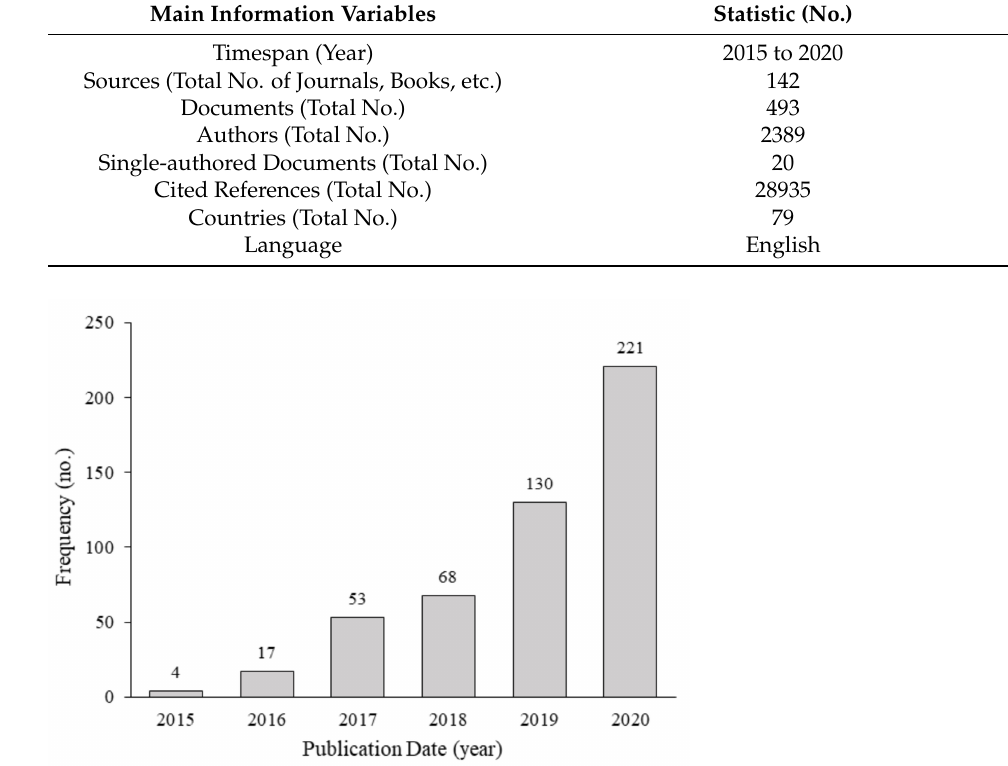
Figure 2. The change in publication frequency over time from 2015–2020 as recorded in the Web of Science for the keyword nature-based